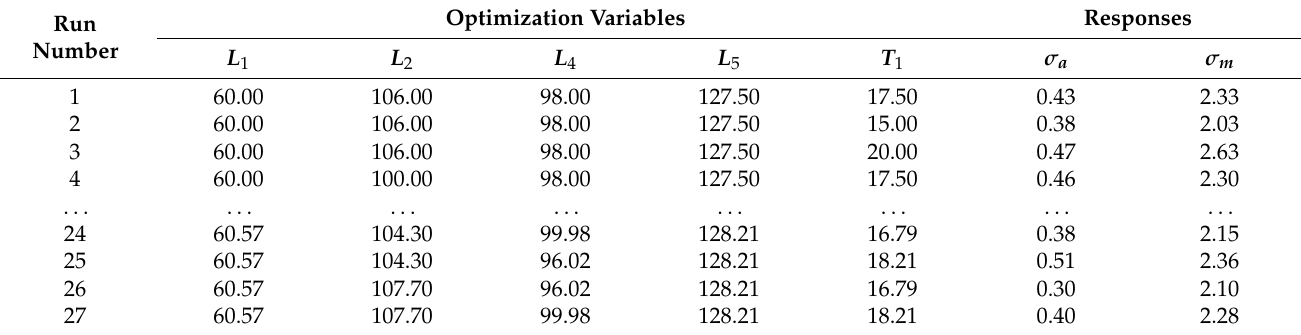
Table 6. DoE design and response values of the first-layer Kriging surrogate model.